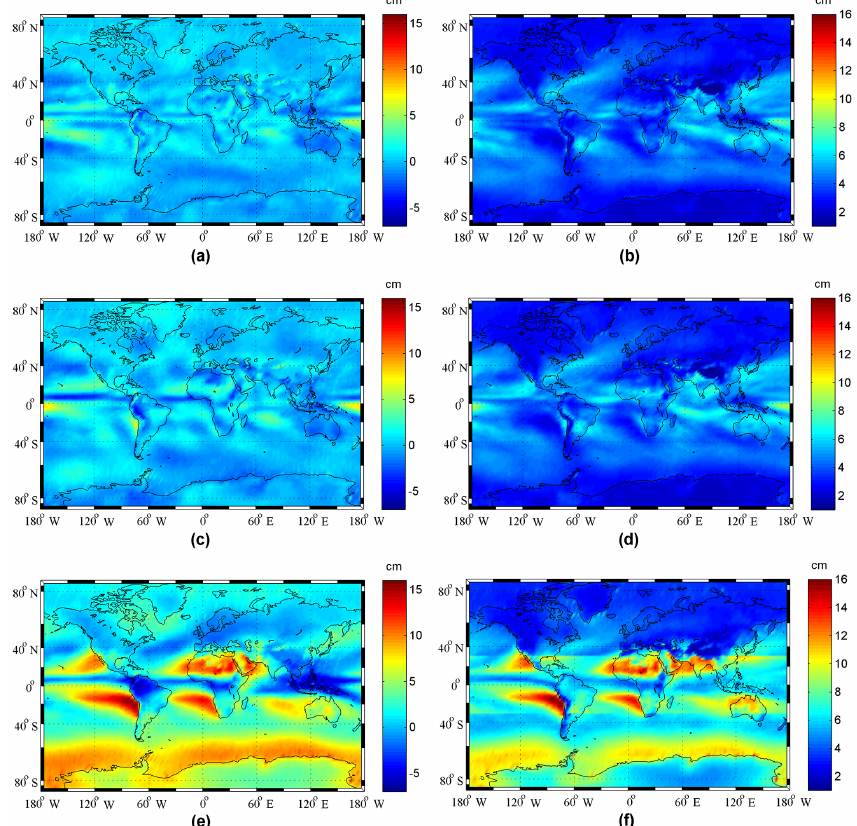
Figure 4. Global distribution of bias and rms of different models. (GZTD2 bias (a) , GZTD2 rms (b) , GZTD bias (c) , GZTD rms (d) , UNB3m bias (e) , UNB3m rms (f)